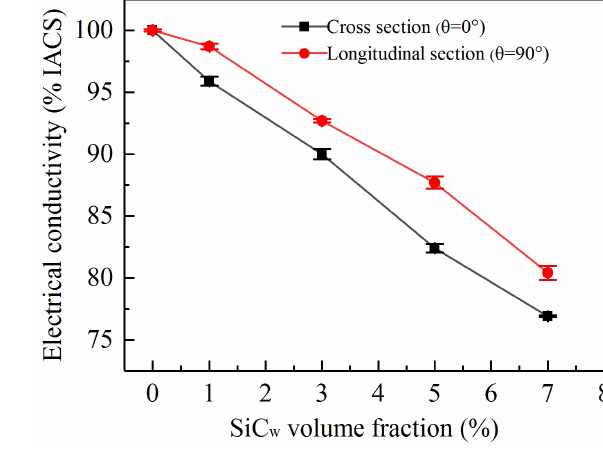
Figure 4: Relative density of SiC w /Cu composites